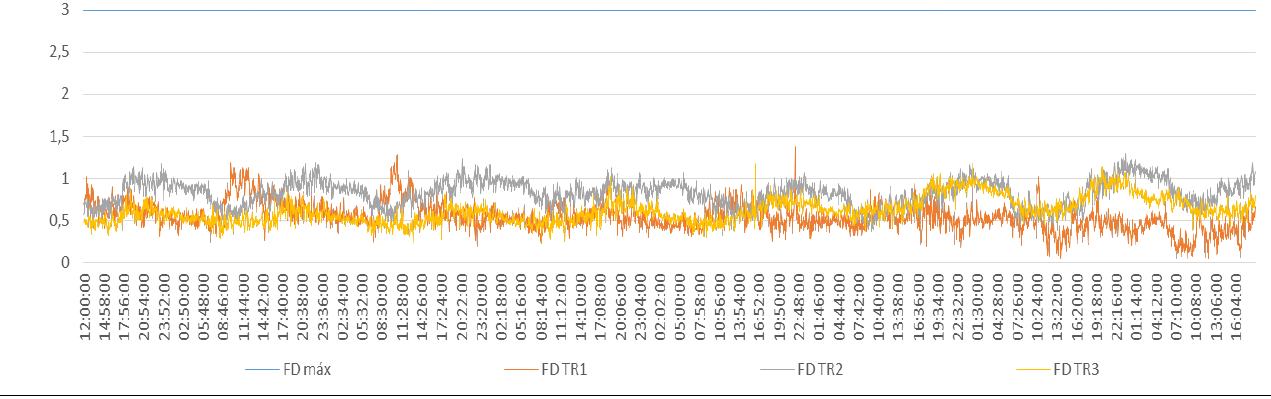
Figure 4: PF indicator graphic.